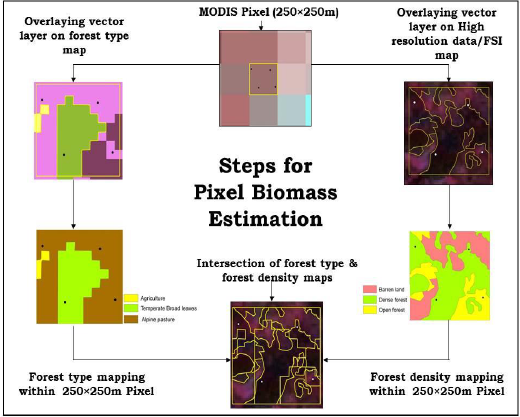
Figure 3. Steps followed in estimating the phytomass at pixel level.